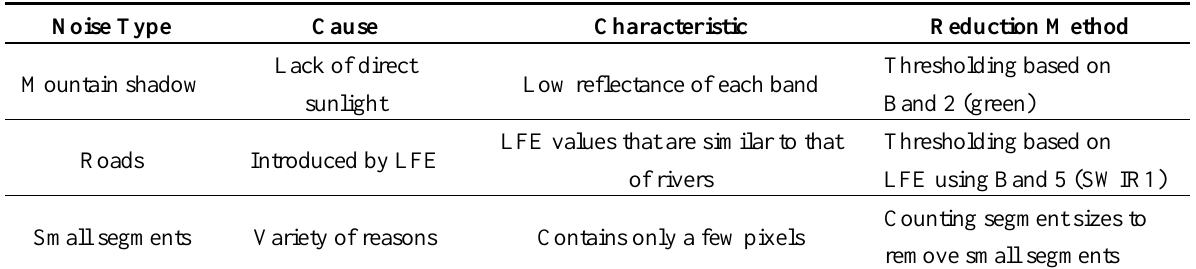
Table 2. Characteristics and reduction methods for three important types of noise. LFE, linear feature